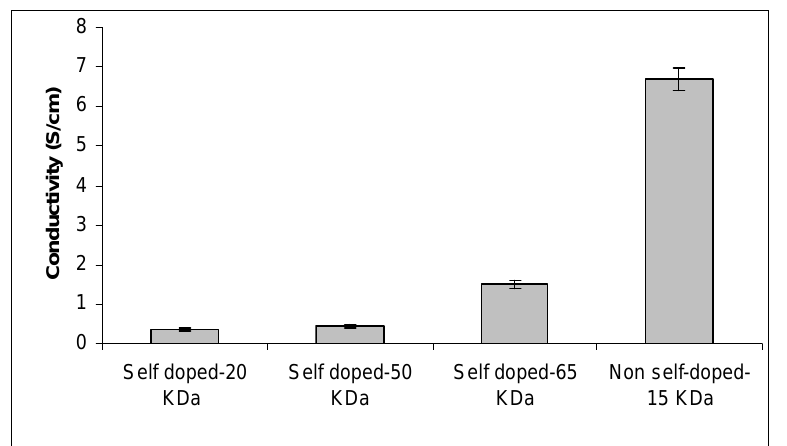
Figure 2 . Conductivity of polyaniline compounds.